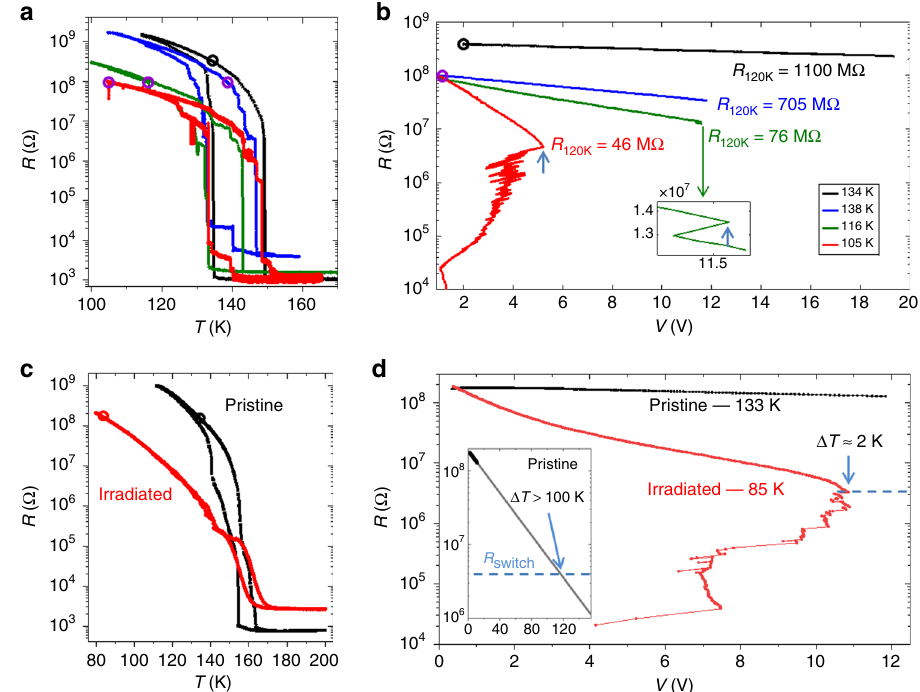
Fig. 3 In fl uence of defects on the switching mechanism. a Resistance vs. temperature curves of four V 2 O 3 nanowires. Open circles denote T 0 for which the R ( V ) curves shown in b were acquired. b R ( V ) for each of the nanowires in a with the corresponding color coding. T 0 is indicated in the legend. Samples with lower insulating state resistance, R 120K , exhibit steeper slopes of log( R ) vs. voltage, indicating enhanced carrier generation. For two samples, abrupt resistance jumps associated with the IMT are observed (light blue arrows). c R eq ( T ) before and after focused ion beam irradiation with a dose of 6.2 × 10 14 Ga ions cm − 2 . Open circles denote T 0 for which the R ( V ) curves shown in d were acquired. d R ( V ) measured in the pristine and irradiated states. Similar to b , the slope of log( R ) vs. voltage is considerably steeper in the irradiated state. After the smooth decrease, the resistance reaches 2% of the initial value, R = 4 M Ω , followed by non-thermal switching with a temperature increase Δ T ~ 2 K. For the pristine state, assuming the same R switch extrapolation of R ( V ) predicts that switching occurs with over 110 V corresponding to a temperature increase of more than 100 K (inset to d